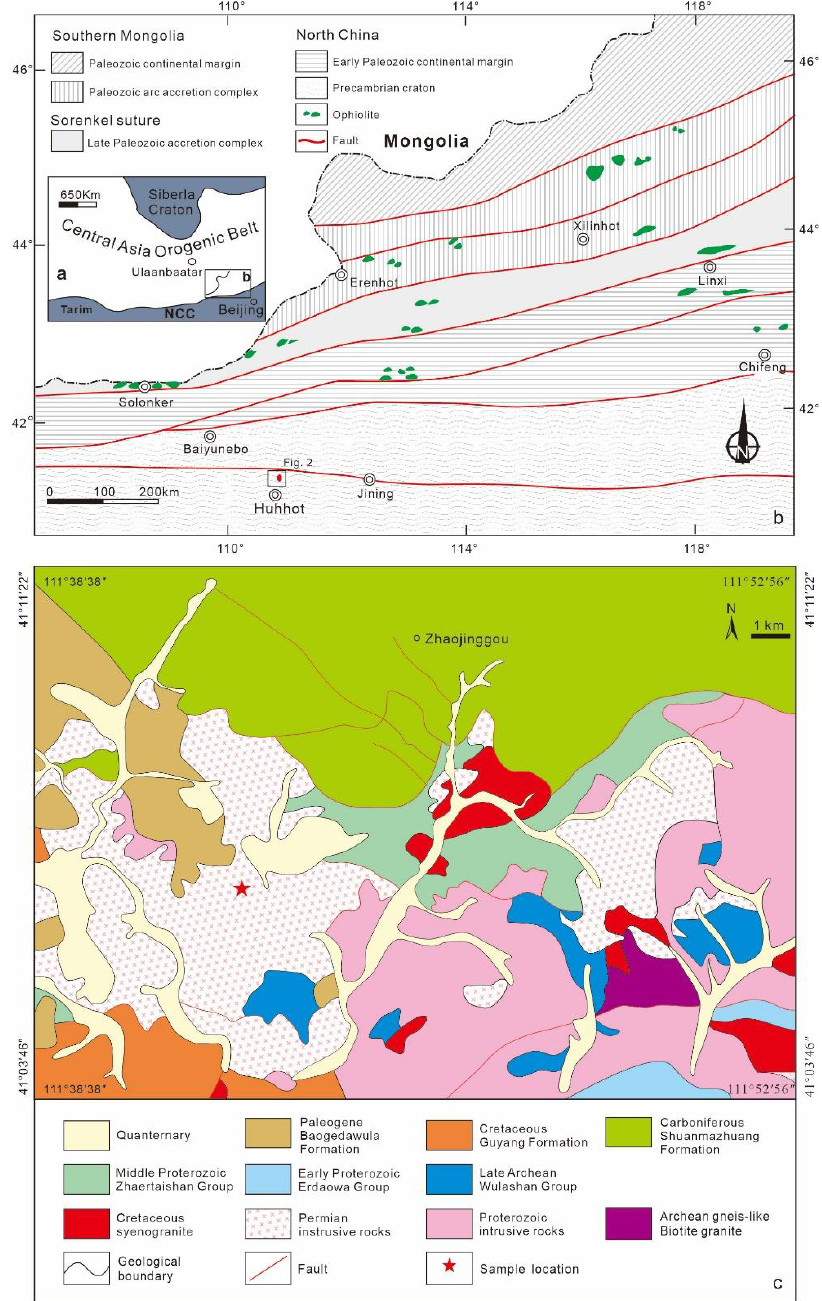
Figure 1. ( a ) Inset showing the location of the Central Asian Orogenic Belt and adjacent continents; ( b ) tectonic sketch showing the suture zone and the study area in Inner Mongolia (modified from [1]); ( c ) geological map of Zhaojinggou pluton and adjacent area (modified from [9]).